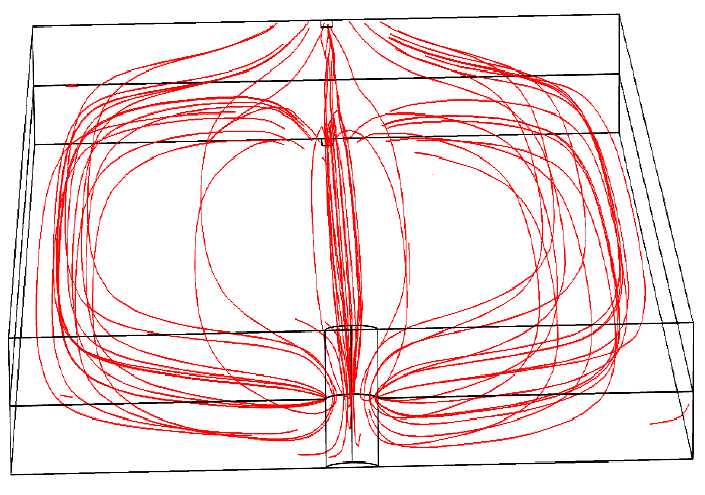
Figure 4. Current flowing inside the lamination and through the short circuit